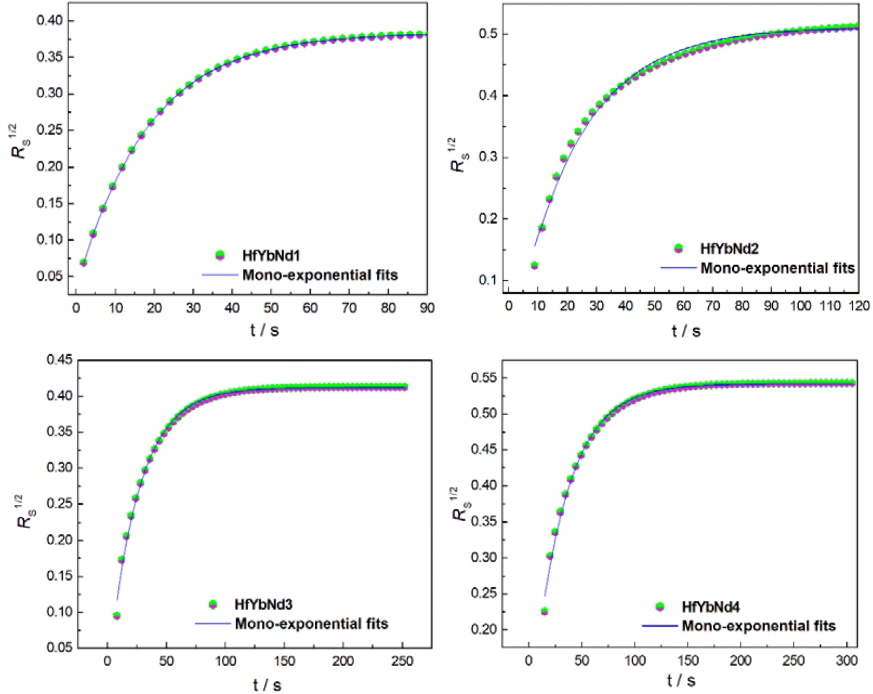
Figure 5. Exposure time dependence of the scattering ratio of Hf:Yb:Nd:LiNbO 3 crystals.